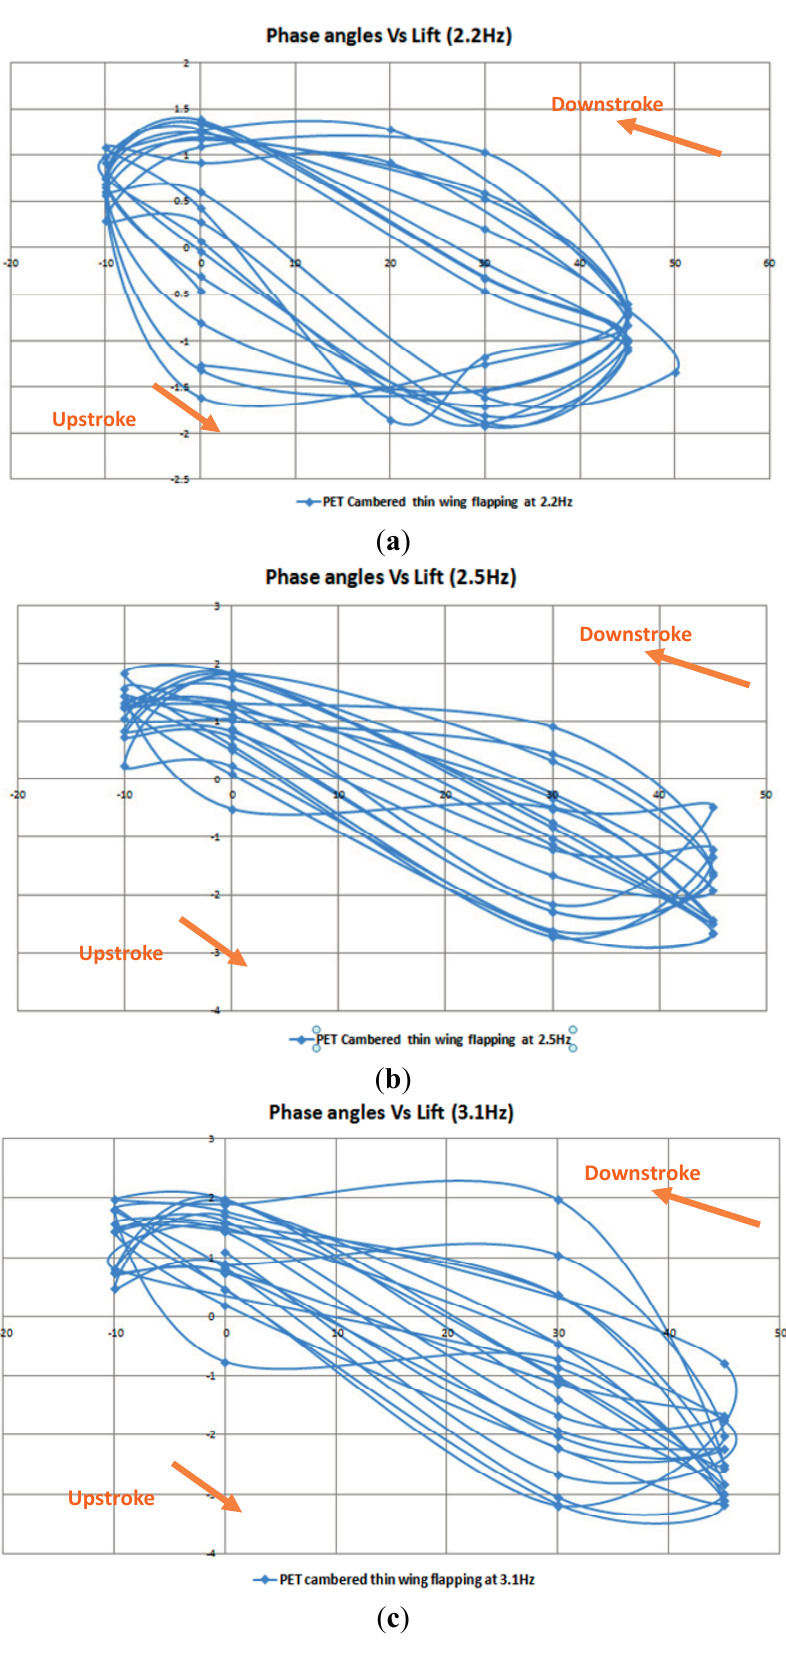
Figure 42. Phase angle vs . lift for PET cambered thin wing. ( a ) Low speed; ( b ) medium speed; ( c ) high